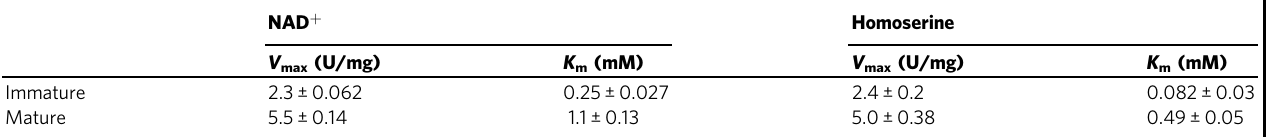
Table 1 Kinetic parameters of immature and mature